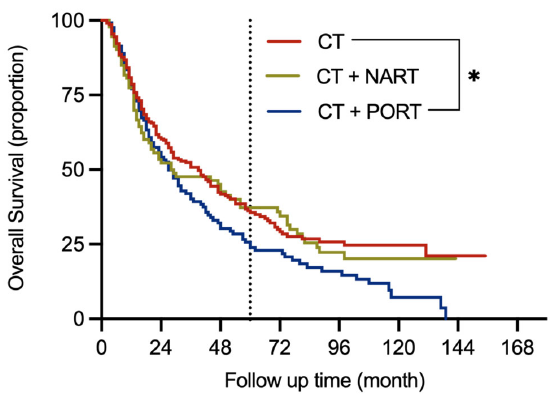
Figure 2. Overall survival in different treatment groups of NSCLC patients with N2 stage after propensity score matching. Note: CT, chemotherapy; NART, neoadjuvant radiotherapy; NSCLC, non-small cell lung cancer; PORT, postoperative radiotherapy; * Indicates significant difference at p < 0.05.